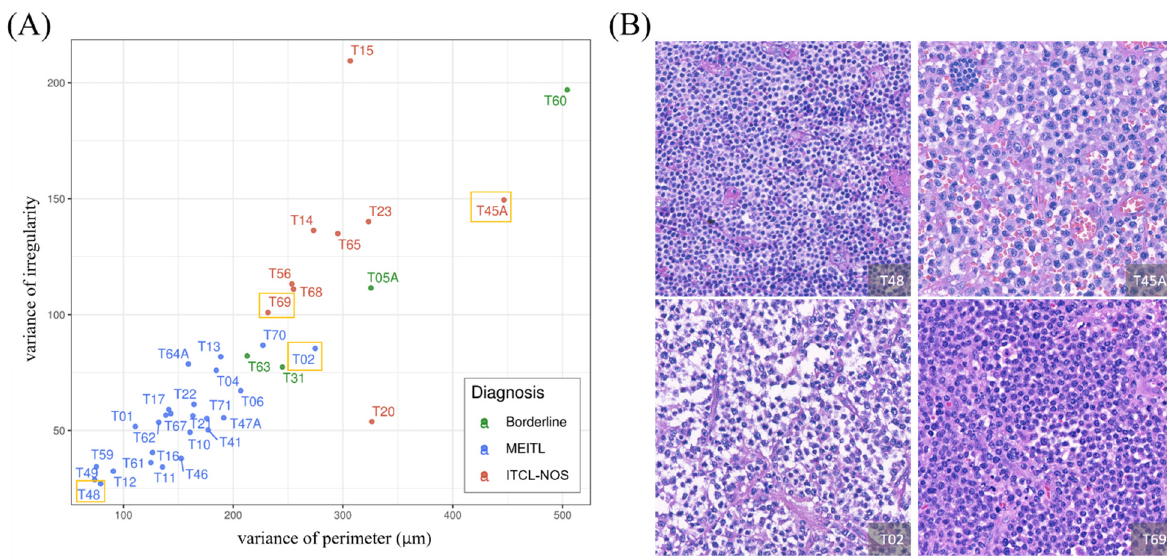
Figure 4. Association between two computed cellular morphometrics. ( A ) The scatter plot of the variance in nuclear perimeter (x-axis) versus the variance in nuclear irregularity (y-axis) of all cases. The MEITL cases, the ITCL-NOS cases, and the borderline cases are represented in blue, green, and red, respectively. ( B ) Representative histological images for MEITL (e.g., case no. T48) are in the lower-left corner of the scatter plot; representative ITCL-NOS cases (e.g., case no. T45A) are shown in the upper-right corner of the scatter plot; atypical cases (e.g., case no. T02 and T69) are located in the middle of the scatter plot.